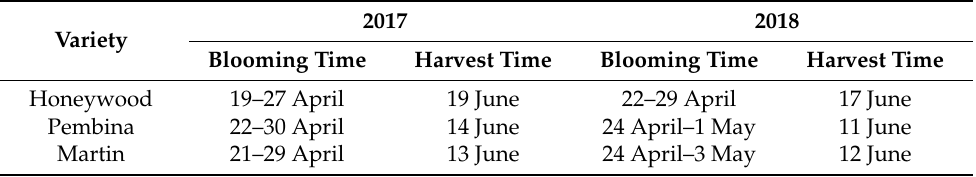
Table 1. The time of bloom and harvest of the tested cultivars in 2017 and 2018. 2017 2018 Variety Blooming Time Harvest Time Blooming Time Harvest Time Honeywood